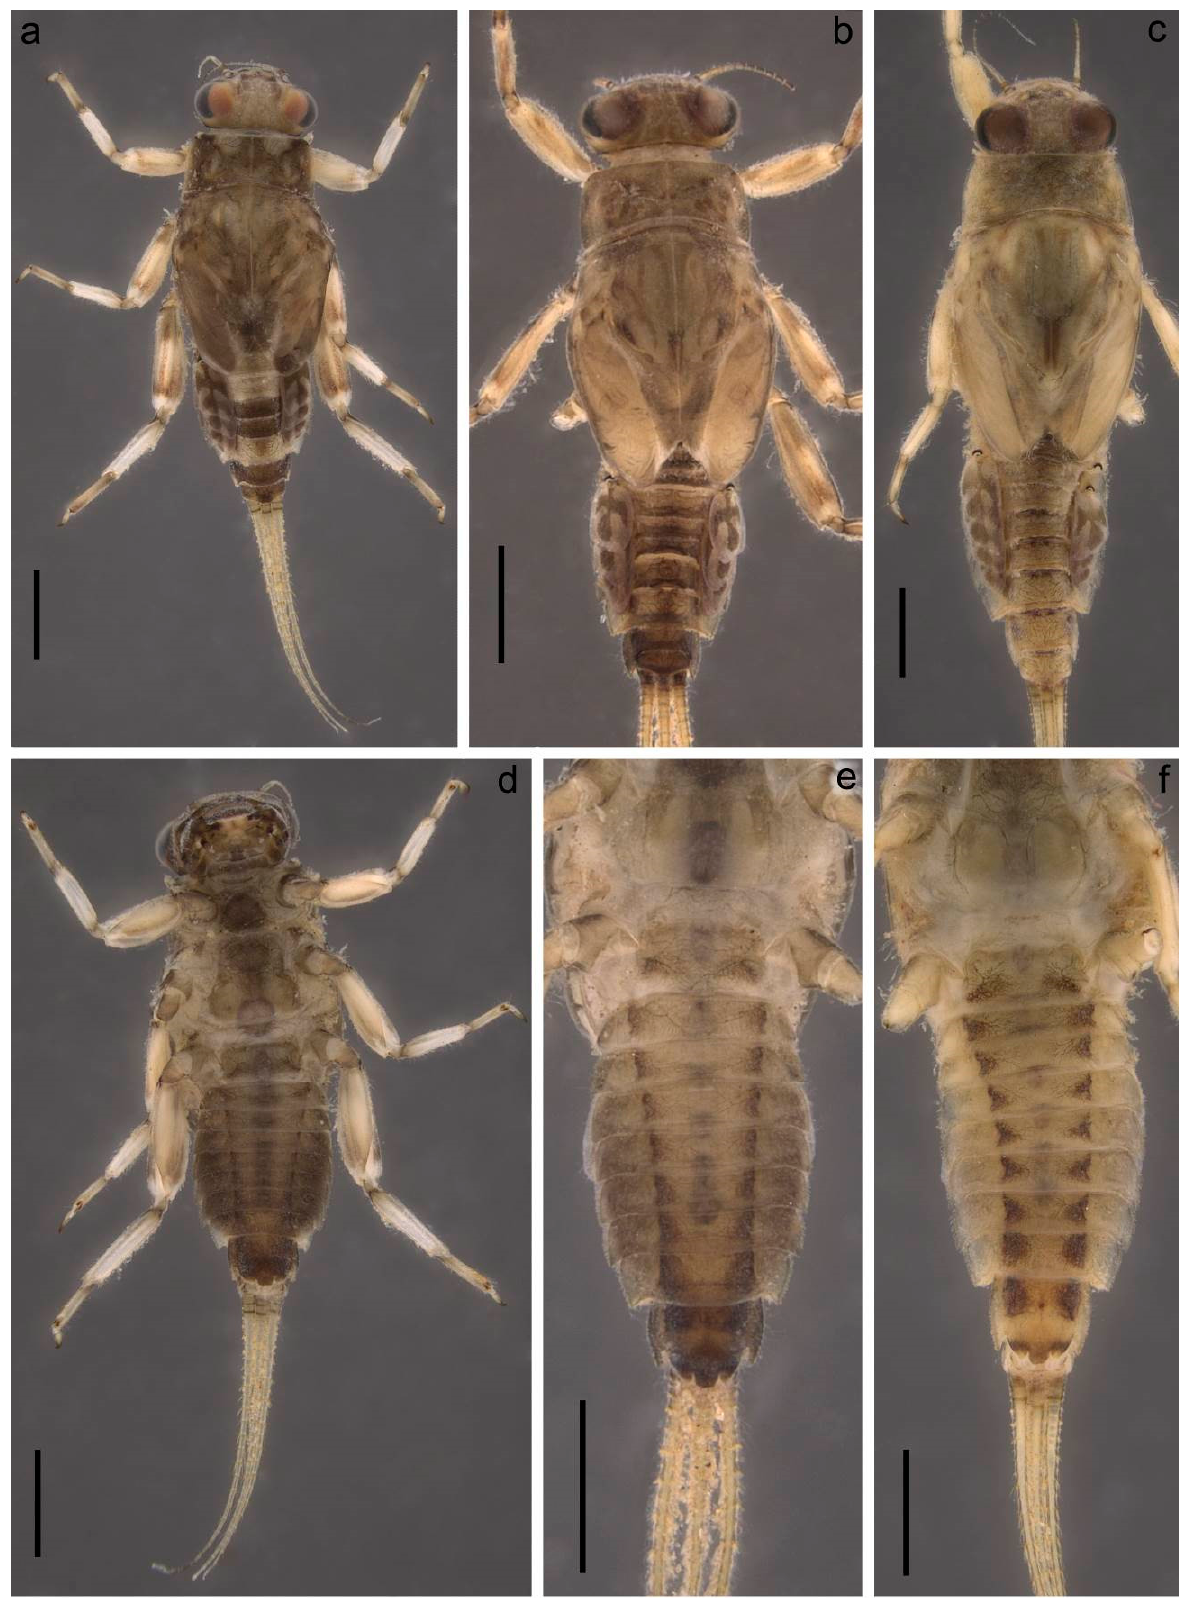
Figure 6. Coloration of larva of Torleya elissa (Jacobus, Zhou & McCafferty, 2009). ( a – c ) Habitus, dorsal view, ( d ) habitus, ventral view, ( e , f ) abdomen, ventral view. Scale bar: 1 mm.